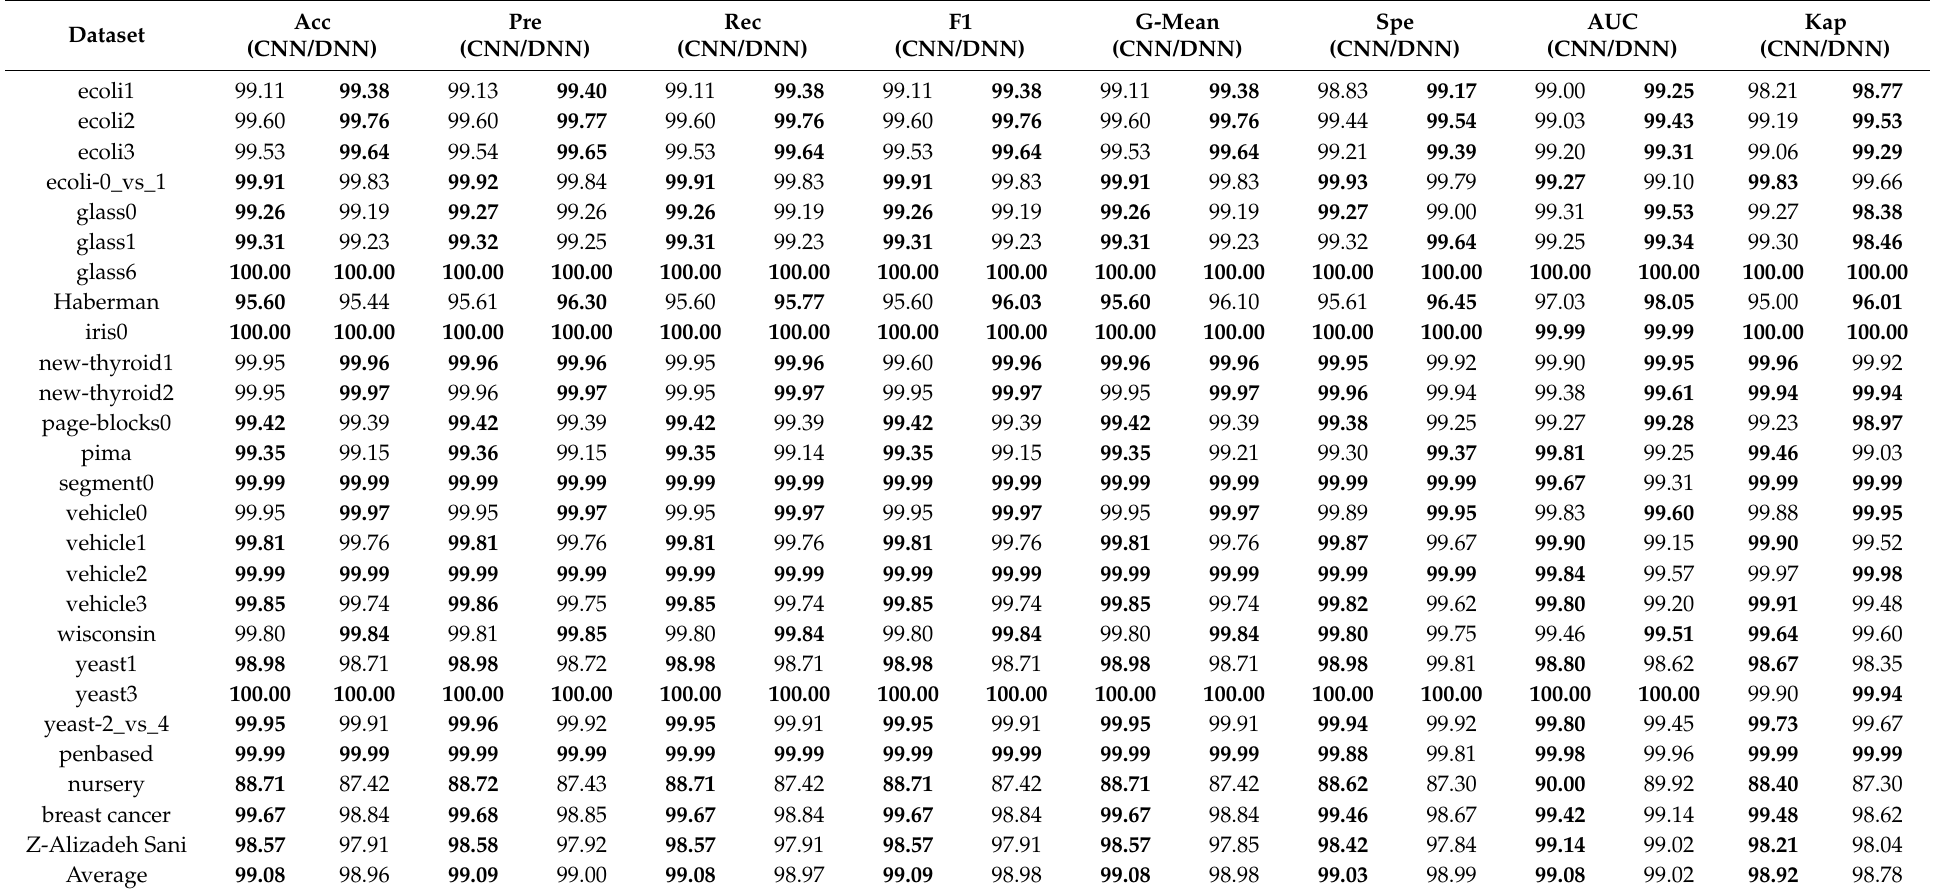
Table 6. SMOTE + NORM. +